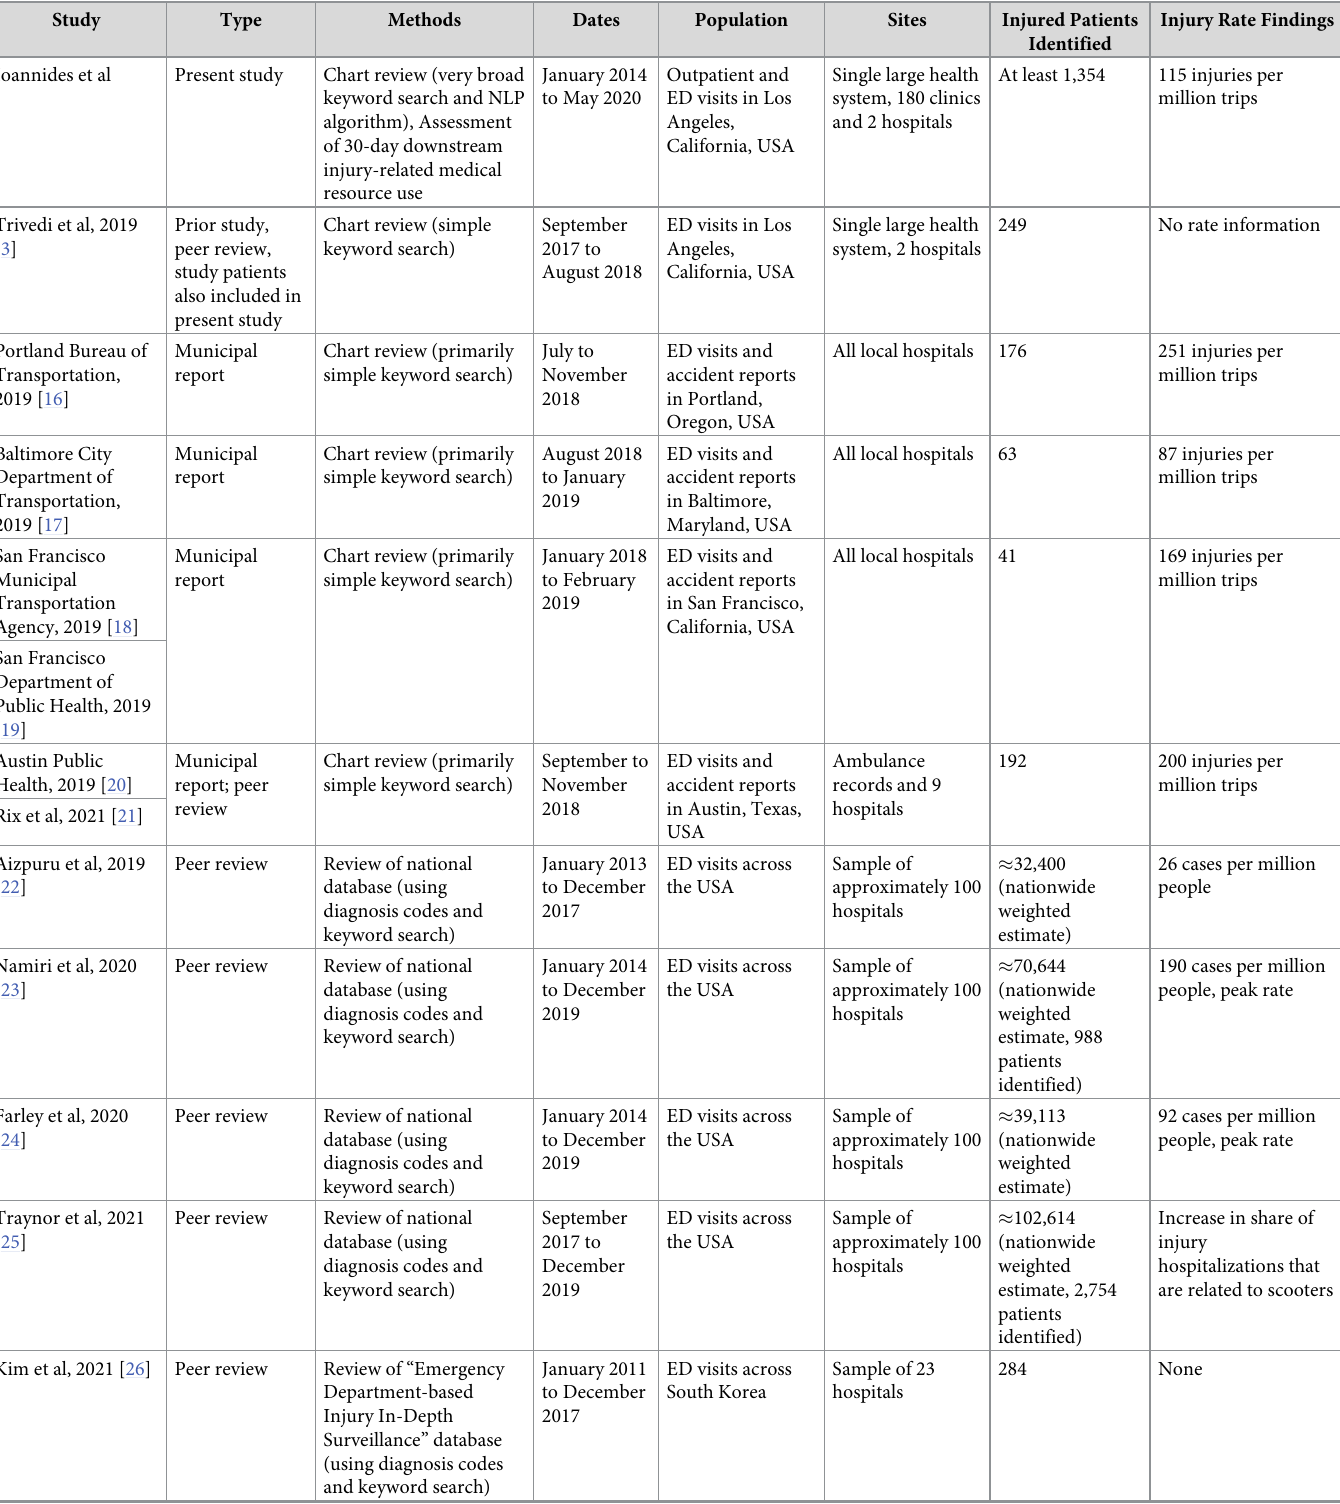
Table 2. Review of significant prior studies on e-scooter